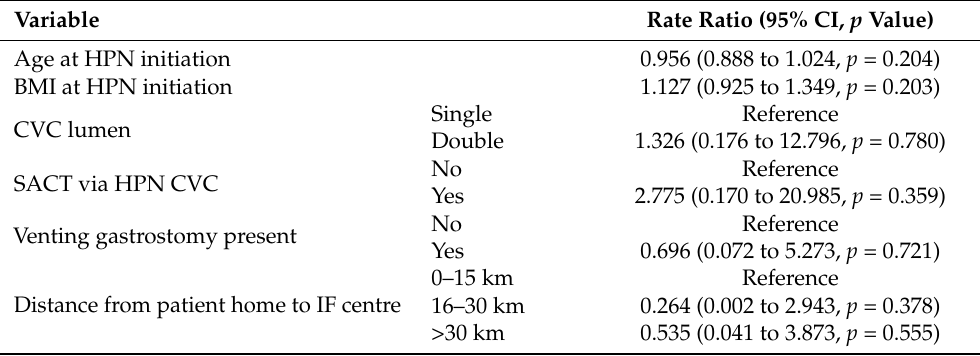
Table 3. Univariate Poisson regression of the factors associated with CRBSI. SACT, systemic anti- cancer therapy.